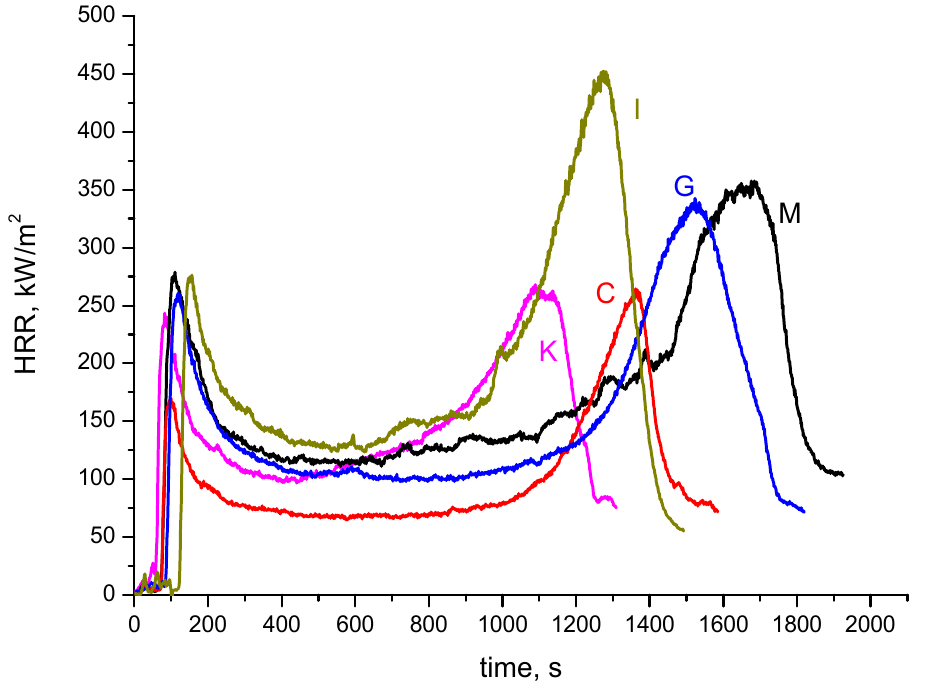
Figure 6. HRR of the samples coated with FR; C—Cumaru, G—Garapa, I—Ipe, K—Kempas, M— Merbau. Cone radiancy at 35 kW/m 2 .